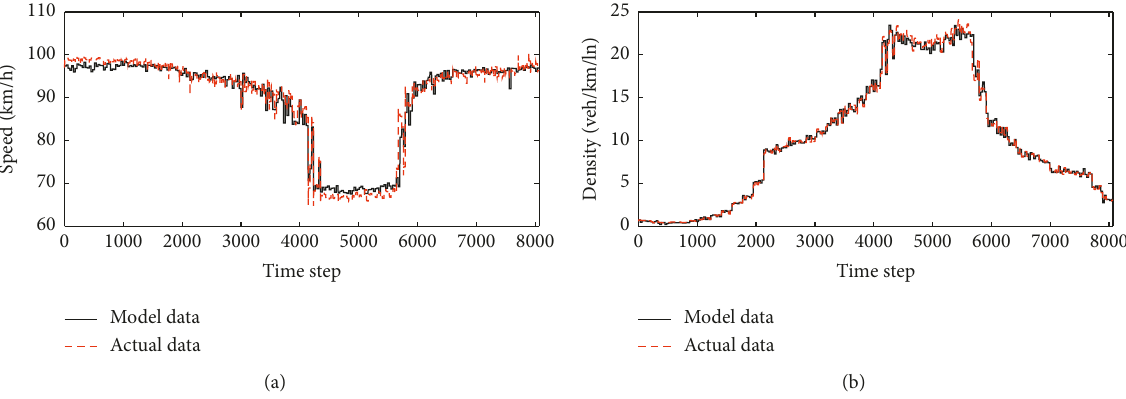
Figure 7: (a) Model speed and actual speed and (b) model density and actual density of case 2.